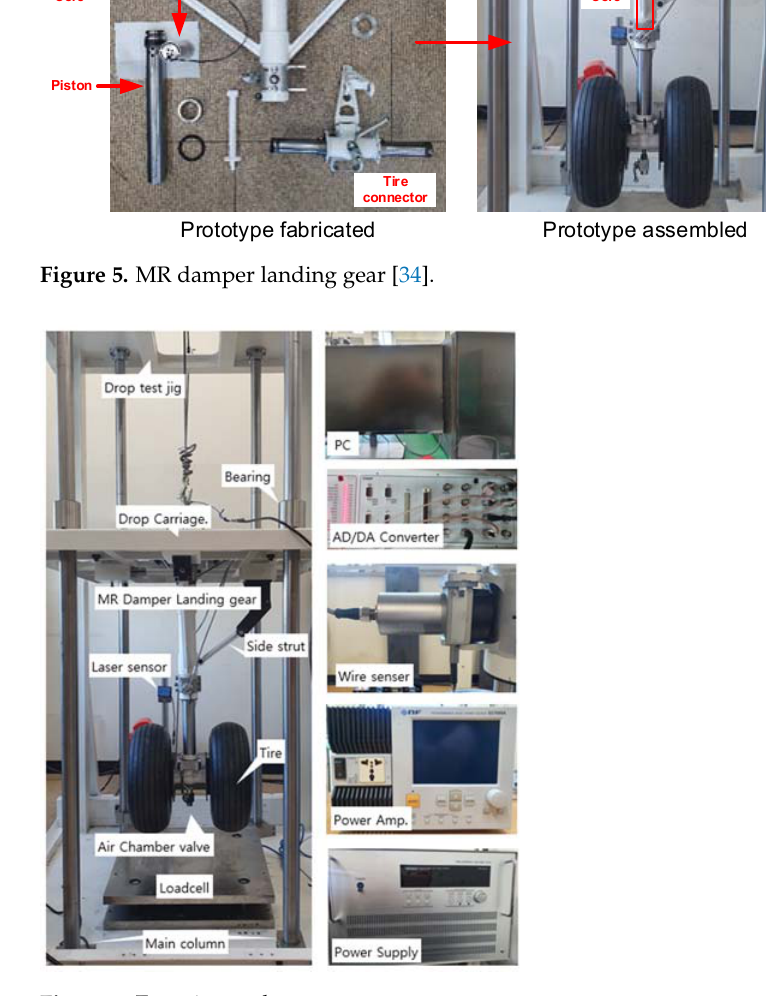
Table 1. Parameters of the MR damper landing gear.